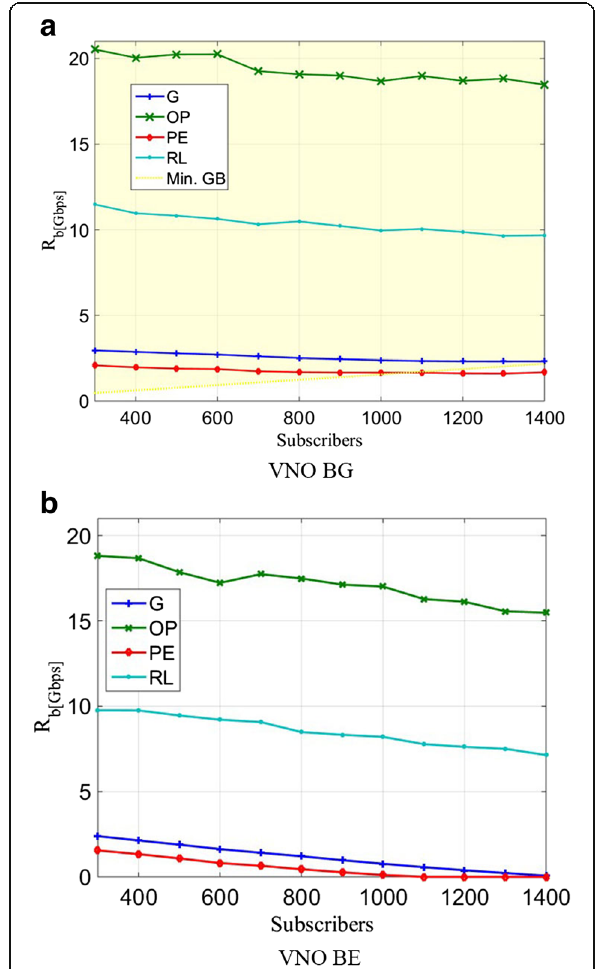
Fig. 9 The data rate allocated to VNOs ( a ) BG and ( b ) BE in different approaches